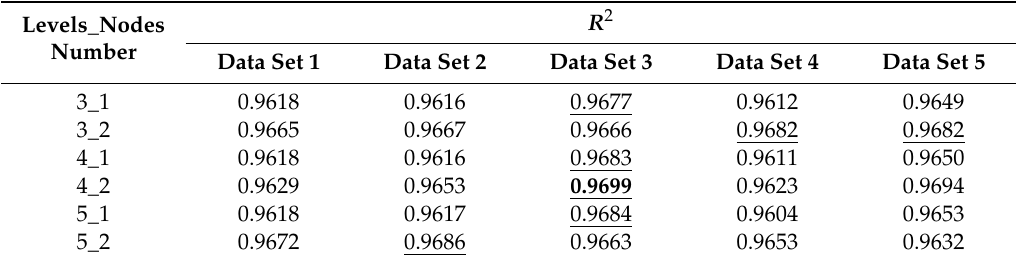
Table 3. Training analysis for FCM clustering.